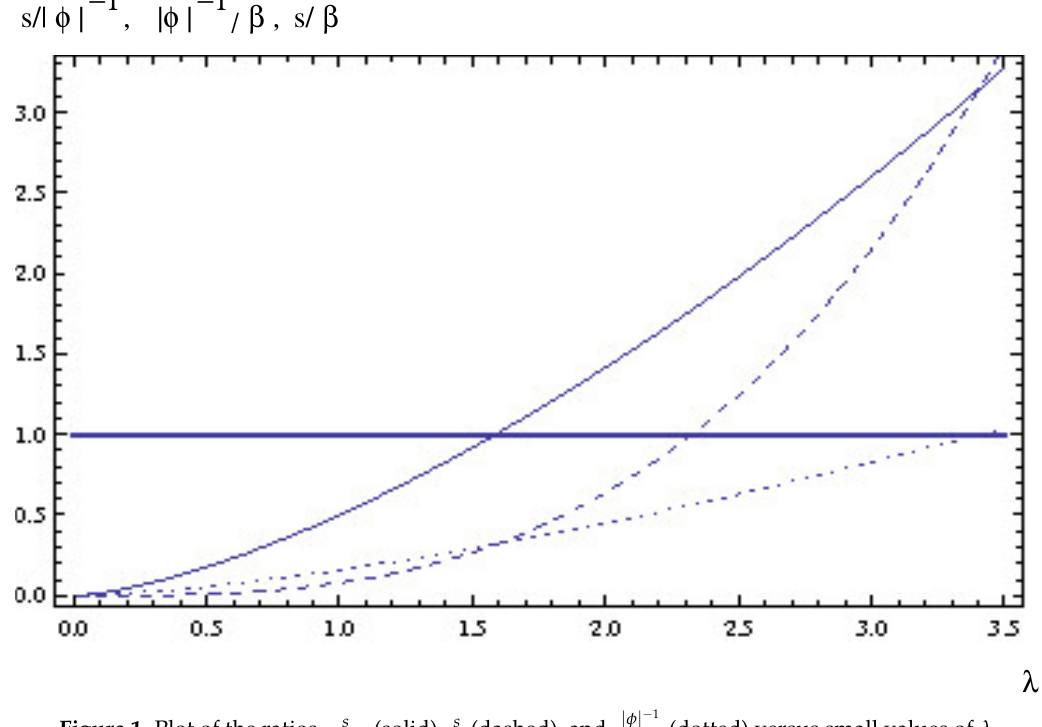
(solid), s (dashed), and | φ | − 1 β